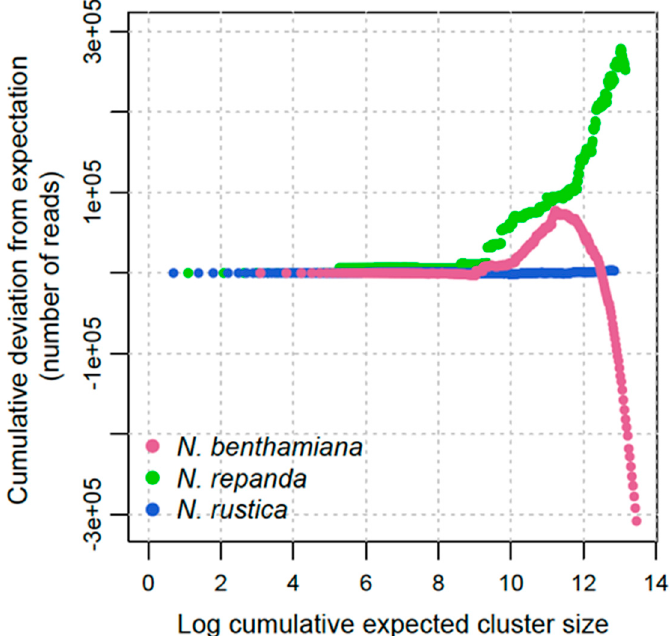
Figure 2. Repeat dynamics for N. rustica (section Rusticae ), N. repanda (section Repandae ) and N. benthamiana (section Suaveolentes ). Curves for each accession represent the absolute cumulative deviation from expectation (sum of parental values). Clusters are ranked from smallest (left) to largest (right), plotted on a natural log scale.